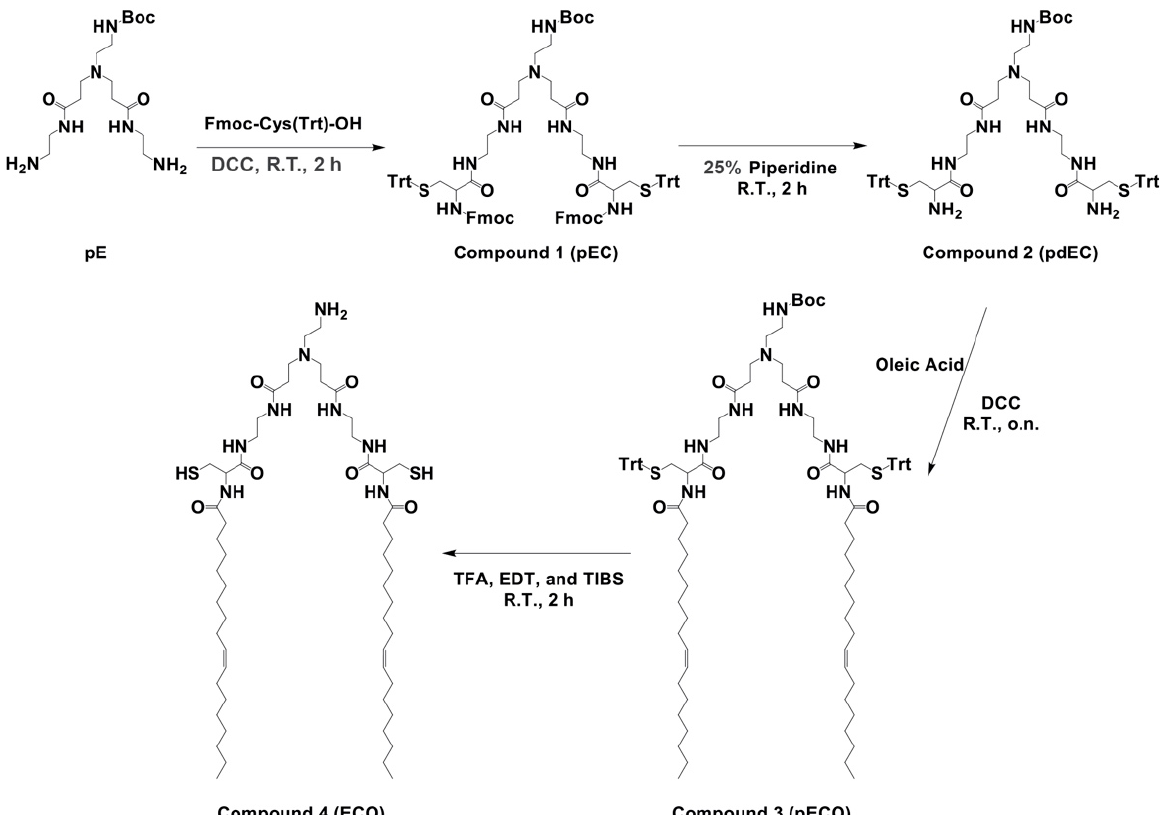
Scheme 1. The schematic representation of overall liquid − phase synthetic procedure of the ECO and its intermediates (pEC, pdEC, and